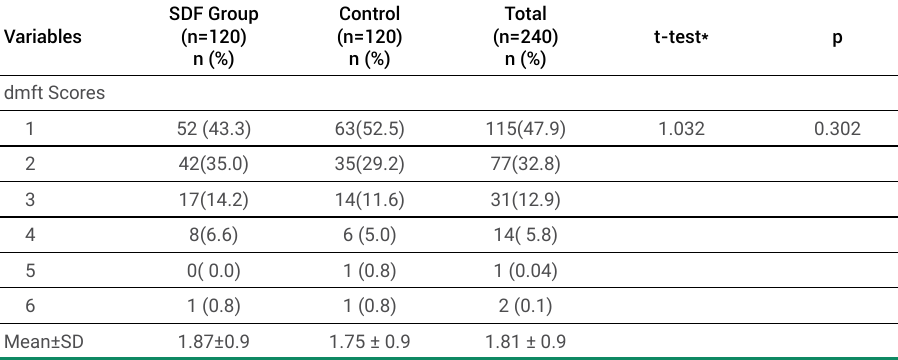
Table 1. Distribution of dmft scores of participants